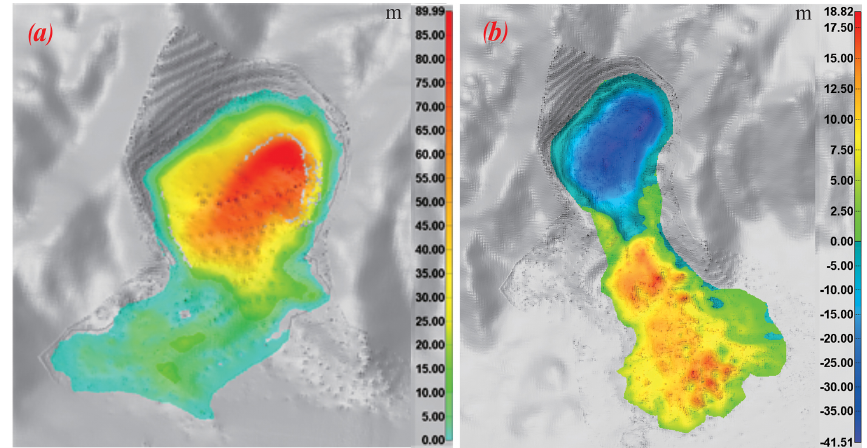
Figure 8. (a) The thickness distribution of the dumpsite based on the pre-/post-disposal DEMs; (b) the elevation variations of the dumpsite estimated between the pre- and post-failure DEMs.